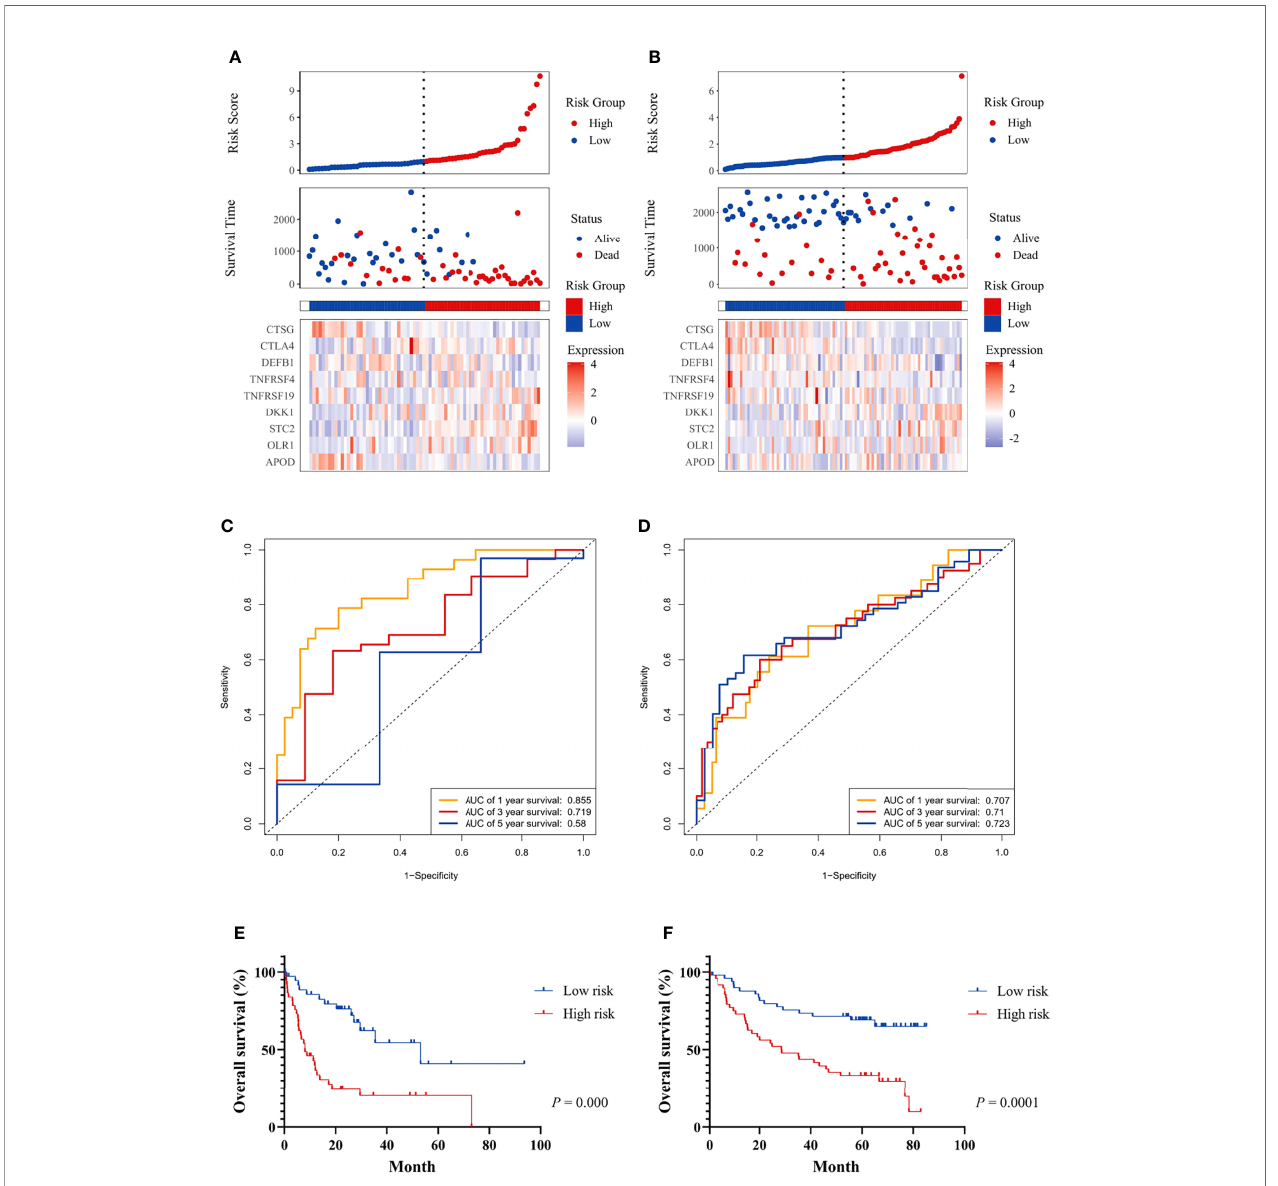
FIGURE 3 | The prognostic signi fi cance of the risk score and survival analysis were evaluated using the GEO validation cohort. The prognostic signi fi cance of risk scores was evaluated using the validation datasets GSE42743 (A) and GSE41613 (B) , respectively. The fi rst from top represents the risk scores distribution of the samples. The intersecting point represents the median of risk scores. The second from top was the distribution of OS status and risk scores. The bottom panel was the heatmap of the mRNA expression of the nine immune-related DEGs. The ROC curve for predicting 1-, 3-, and 5-year overall survival probability in GSE42743 (C) and GSE41613 (D) . Kaplan – Meier curves for the survival rate of OSCC patients between the high-risk and low-risk groups in GSE42743 (E) and GSE41613 (F) . P values for signi fi cance (<0.05) calculated using Cox regression